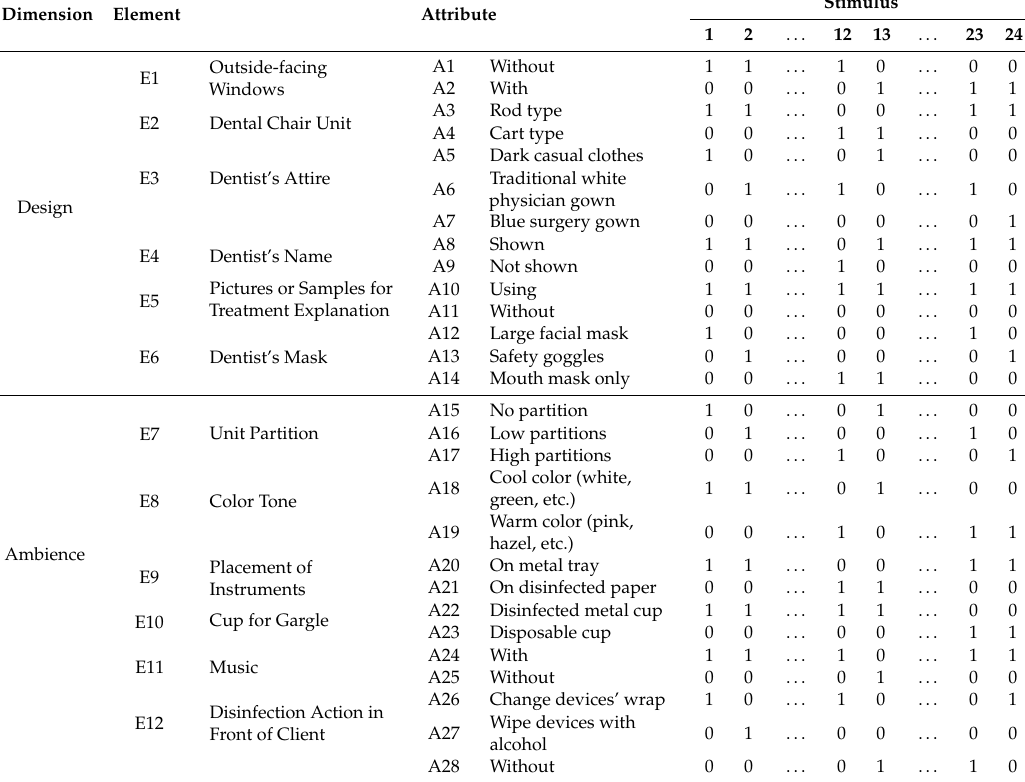
Table 1. Abbreviated table of property space and stimulus